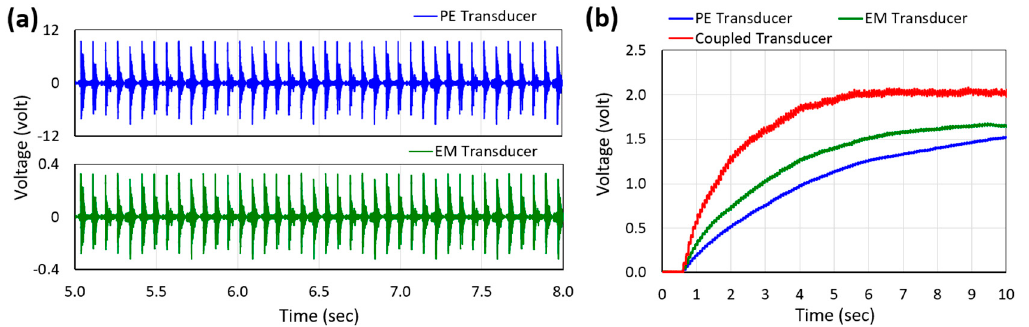
Figure 10. Voltage waveforms generated by each transducer ( a ) and accumulated rectified and multiplied voltages across the storage capacitor ( b ) as a function of time while excited by human-limb motion.